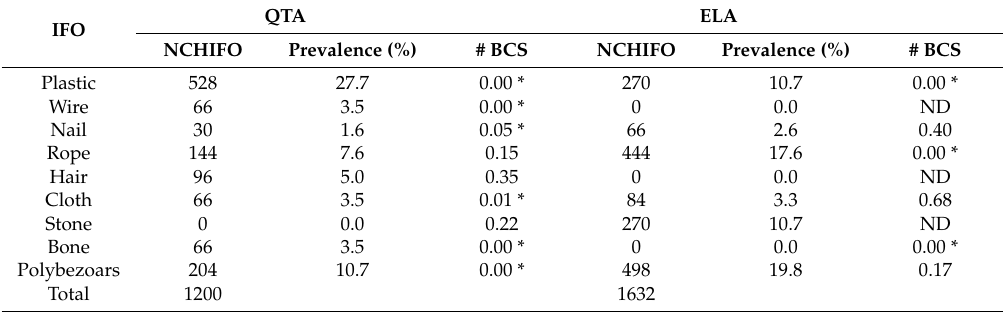
Table 1. Type and prevalence of indigestible foreign objects at QTA ( n = 1906) and ELA ( n = 2518). IFO